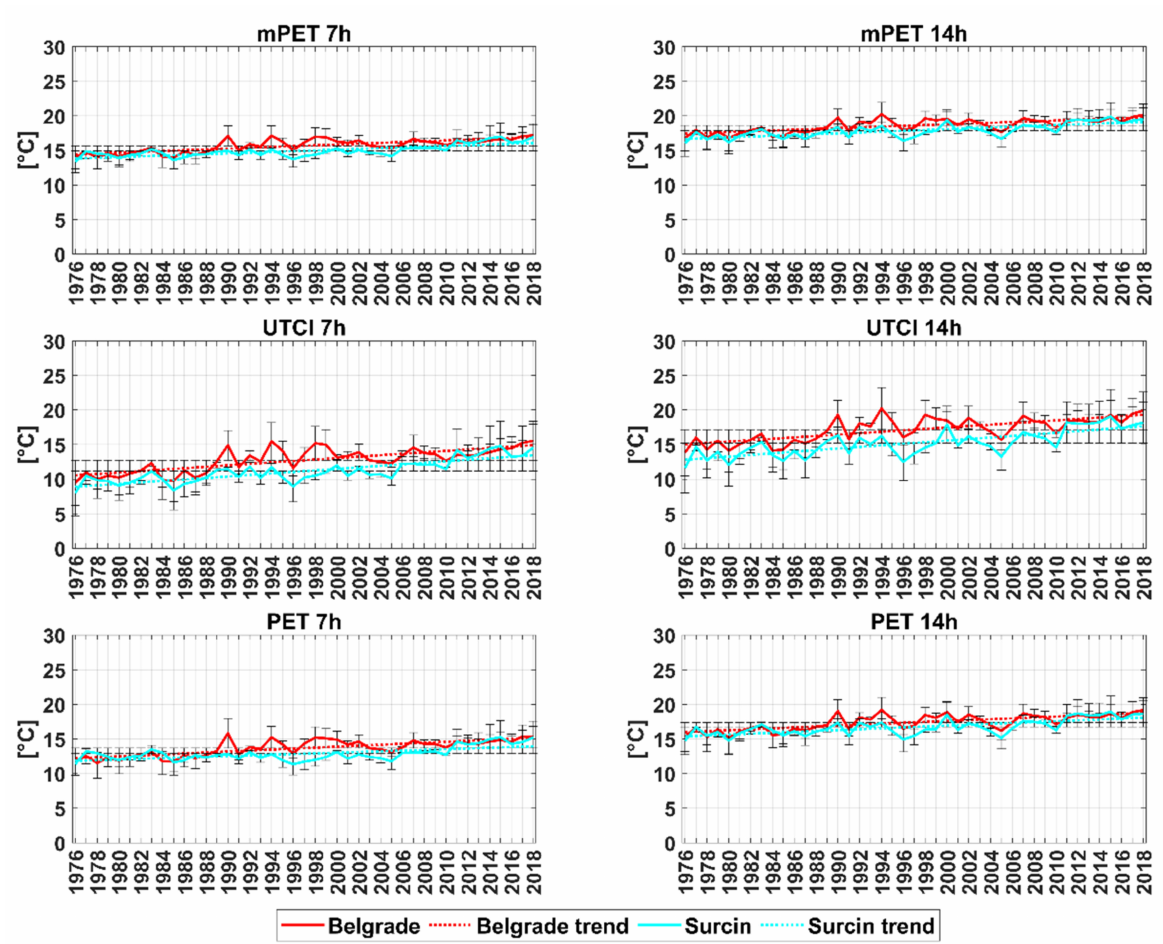
Figure 4. The average annual UTCI, PET and mPET at 7 h and 14 h CET during the period (1976–2018). Red lines and red dotted lines: Belgrade and trend, blue lines and dotted blue lines: Surcin and